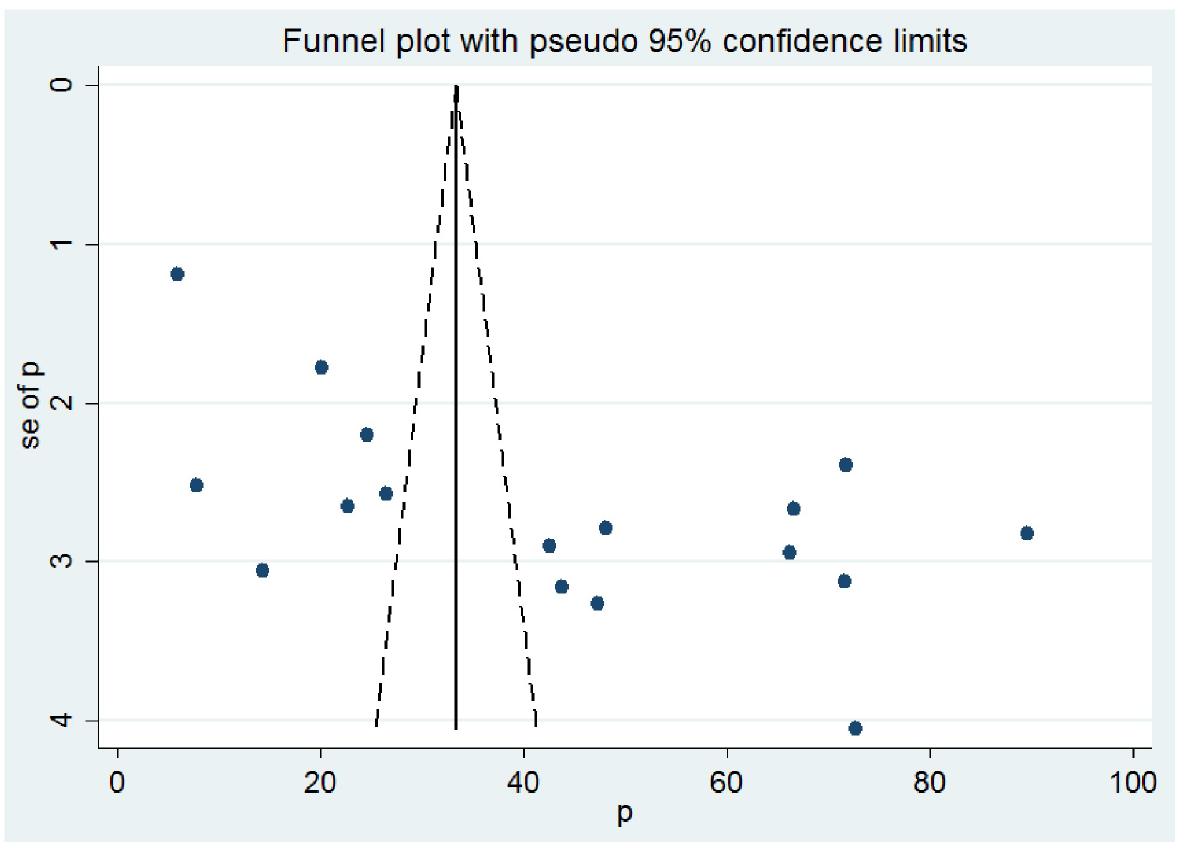
Fig 5. Funnel plots showing publication bias test of the included studies in this meta-analysis.